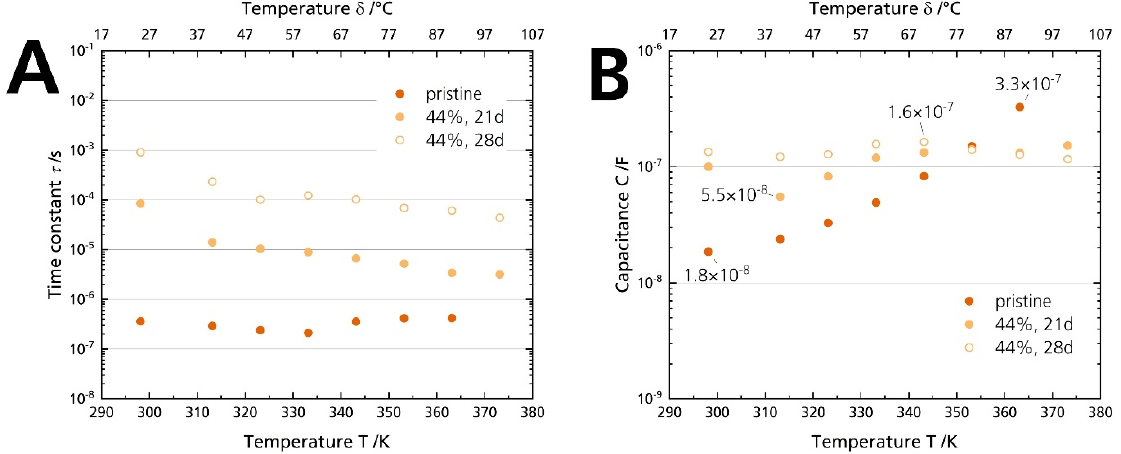
Figure 12. ( A ) Time constants and ( B ) capacitances calculated with Equation (3) from the PEIS measurements of the pristine sample and the specimens stored for 21 days and 28 days in 44% r.h.